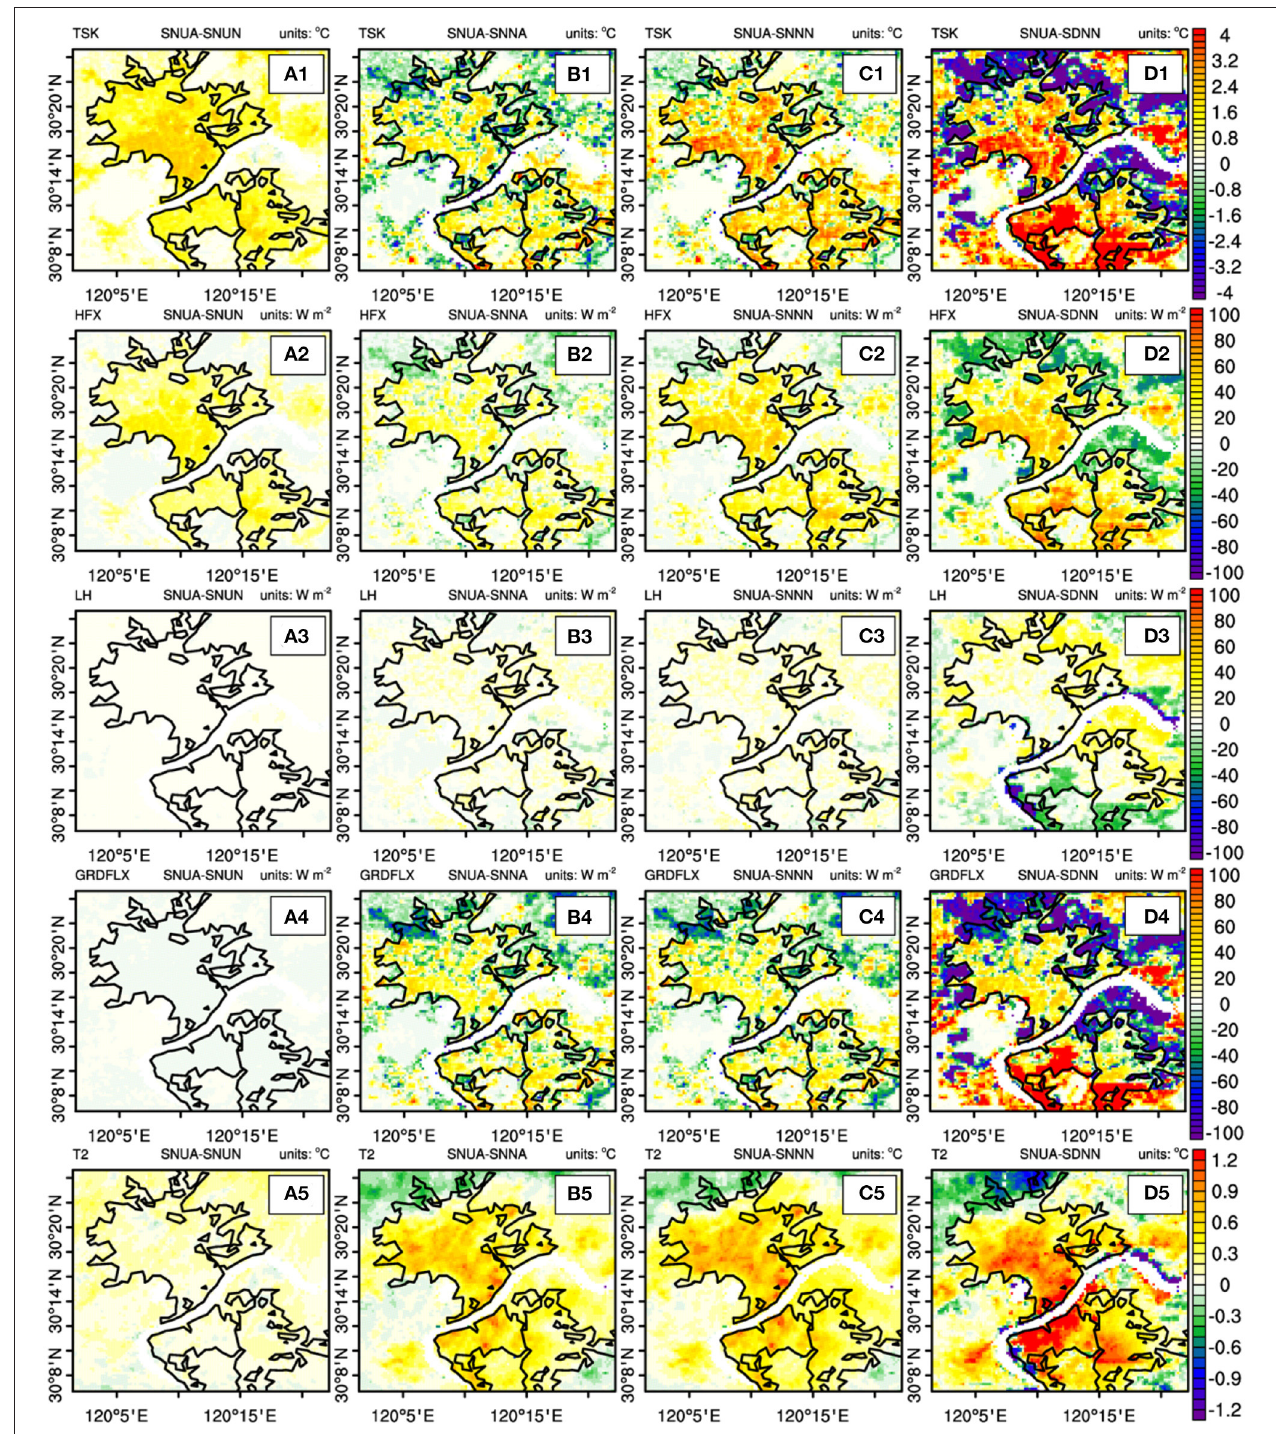
FIGURE 12 | Difference in (A1–D1) surface temperature( ◦ C), (A2–D2) sensible heat flux (W m − 2 ), (A3–D3) latent heat flux (W m − 2 ), (A4–D4) ground heat flux (W m − 2 ), (A5–D5) temperature at 2m ( ◦ C) at night between SNUA run to SNUN run (A1–A5) , SNNA run (B1–B5) , SNNN run (C1–C5) , SDNN run (D1–D5) .